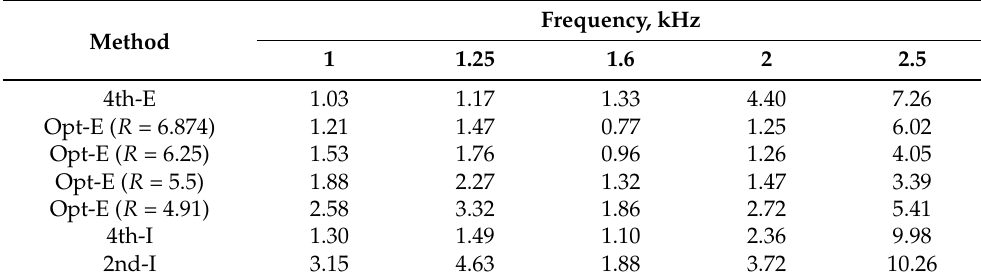
Figure 8. Comparisons of SPL spectra above 1.8 kHz at receiver ( x , y , z ) = (0.6, 0.5, 0.5): ( a ) the reference solution vs. Opt-E TD-FEM (optimized at R = 6.87) and ( b ) the reference solution vs. Opt-E TD-FEM (optimized at R = 6.25), ( c ) the reference solution vs. Opt-E TD-FEM (optimized at R = 5.5) and ( d ) the reference solution vs. Opt-E TD-FEM (optimized at R = 4.91). Table 2. Comparison of e EDT (%) among various TD-FEMs.